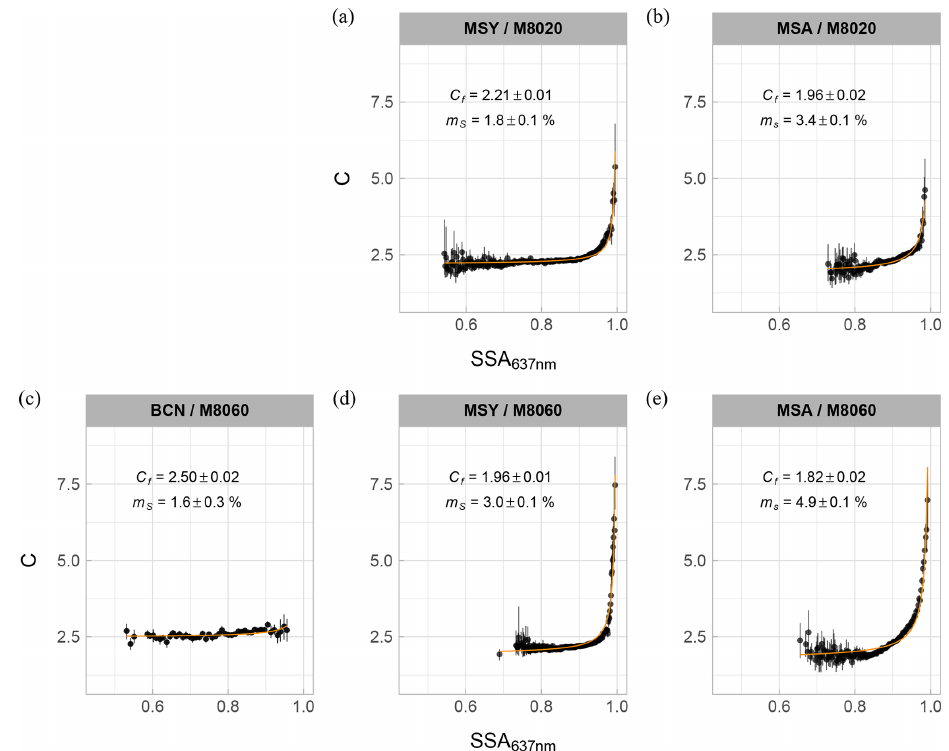
Figure 1. Cross-sensitivity to scattering analysis for TFE-coated glass tape (also known as M8020; a , b ) and M8060 filter tape (c–e) for the BCN (c) , MSY (a, d) and MSA (b, e) stations obtained by attenuation coefficients from the AE33, absorption coefficients from the MAAP and scattering coefficients from the integrating nephelometer. Each data point represents the mean and the vertical bars the first and third quartile for each bin. The multiple-scattering constant, C f , and cross-sensitivity to scattering, m s , are determined by fitting Eq. (9) to the binned data. Table 1. AE33 multiple-scattering parameter C for some measurement stations (including BCN, MSY and MSA, in italics) and cross- sensitivity to scattering for the BCN, MSY and MSA stations compared to literature values for AE33 TFE-coated glass (M8020). Different approaches, as mentioned in Sect. 3.2, have been used to obtain the factor C . Since the literature values are obtained through either one of the methods, we include these values in their corresponding column ( C or C Deming